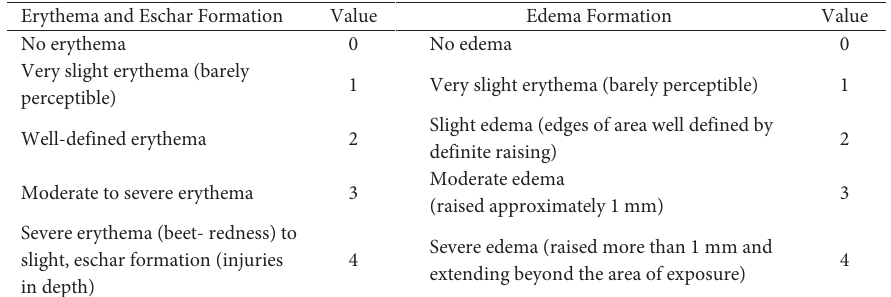
Table 2. Draize dermal irritation scoring system (DDISS)